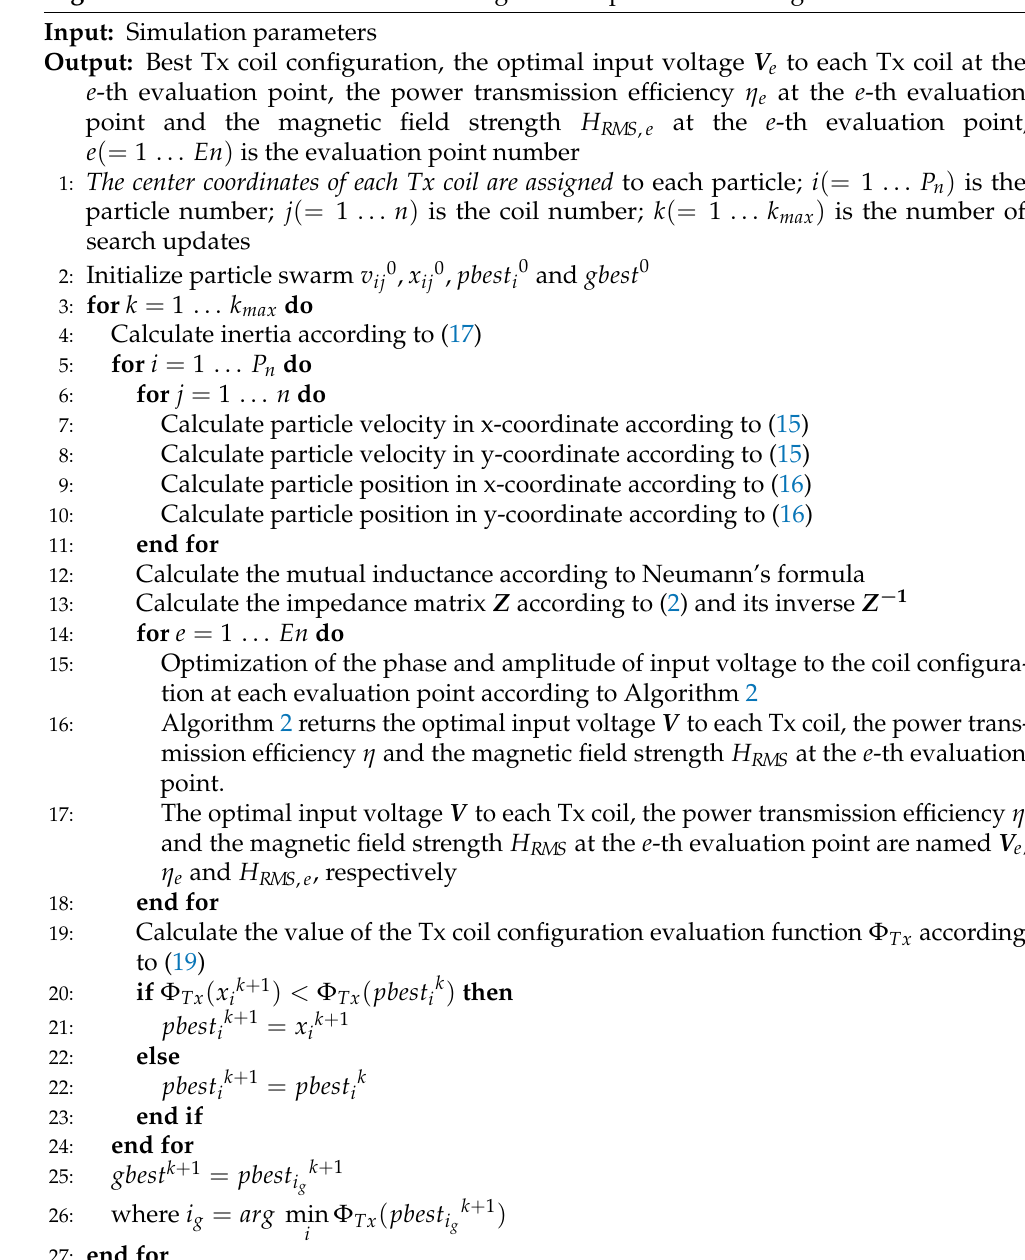
Algorithm 1. The pseudo code for input voltage optimization using PSO is shown in Algorithm 2. Algorithm 1 Pseudo code of Tx coil configuration optimization using